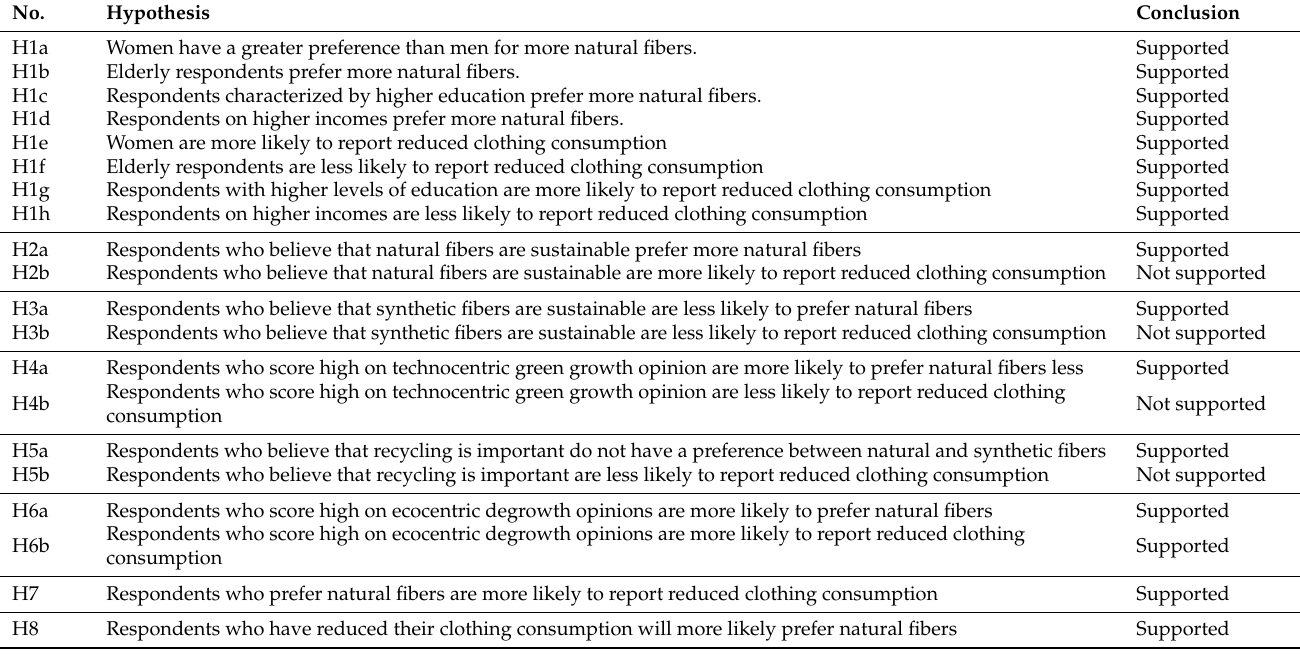
Table 7. Summary of hypothesis testing results.